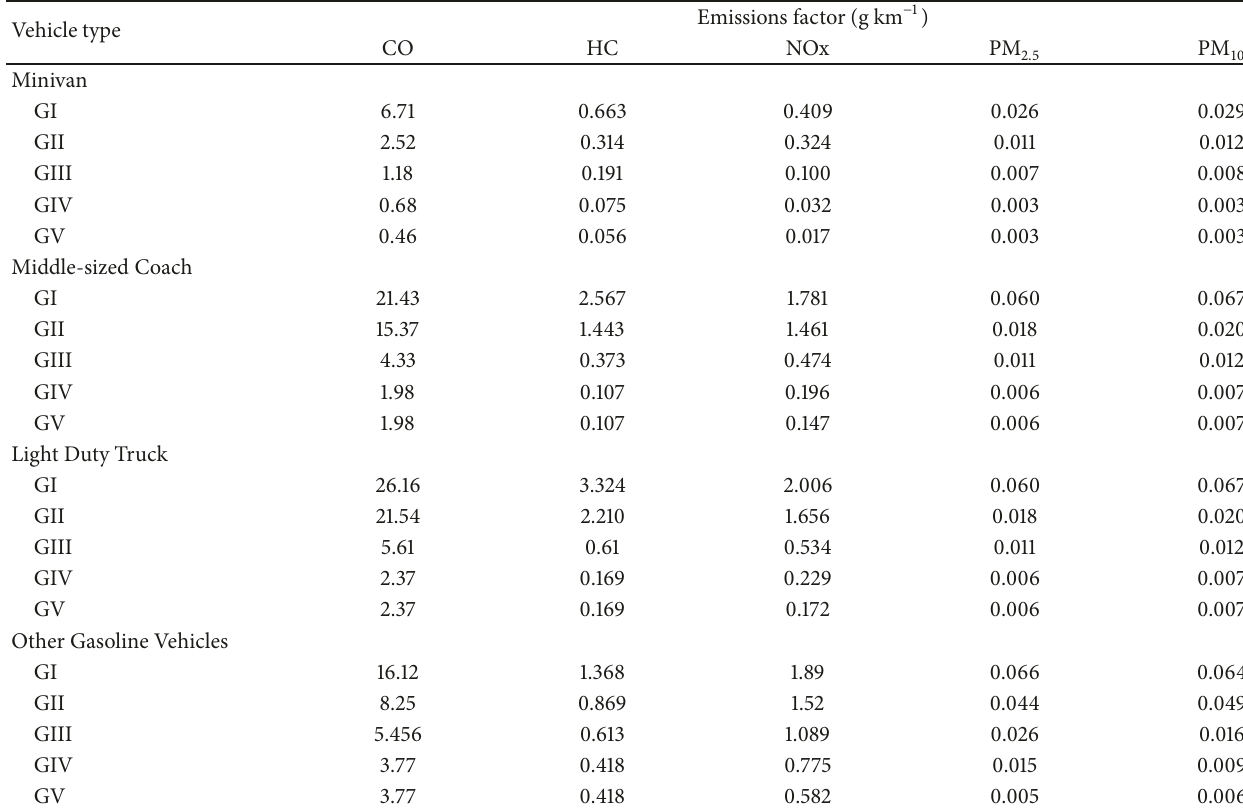
Table 1: Emission factors for different types of gasoline vehicles.